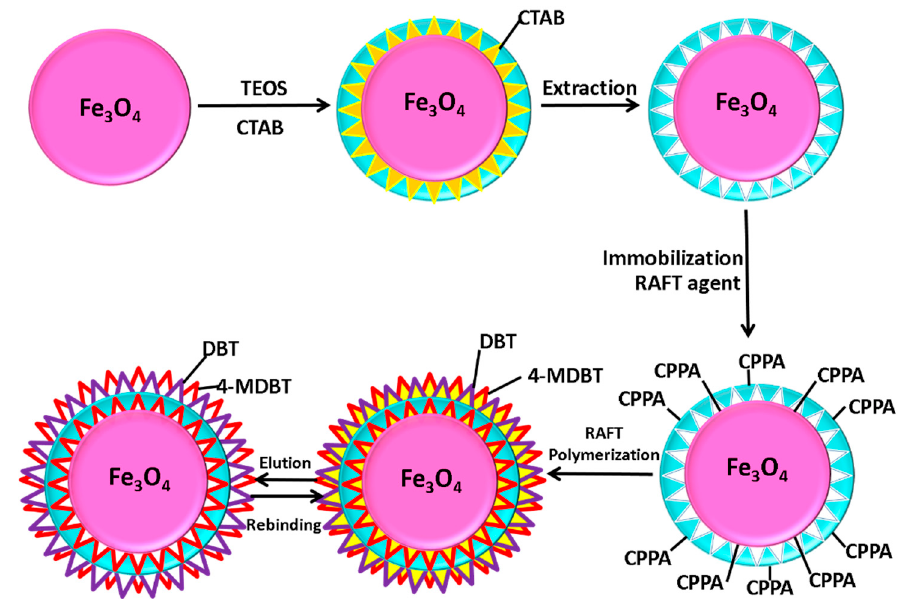
Figure 8. Schematic illustration for the preparation of functionalized magnetic mesoporous silica (Fe 3 O 4 @mSiO 2 @DT-MIP) covered with double template molecular imprinted polymer (MIP) [141].